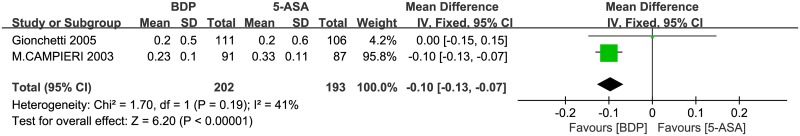
Forest plot of randomized controlled trials of BDP vs. 5-ASA in inducing Reduction of DAI parameters: physician-derived disease activity scores, in ulcerative colitis.BDP, beclomethasone dipropionate. 5-ASA, mesalazine. M-H, Mantel-Haenszel.